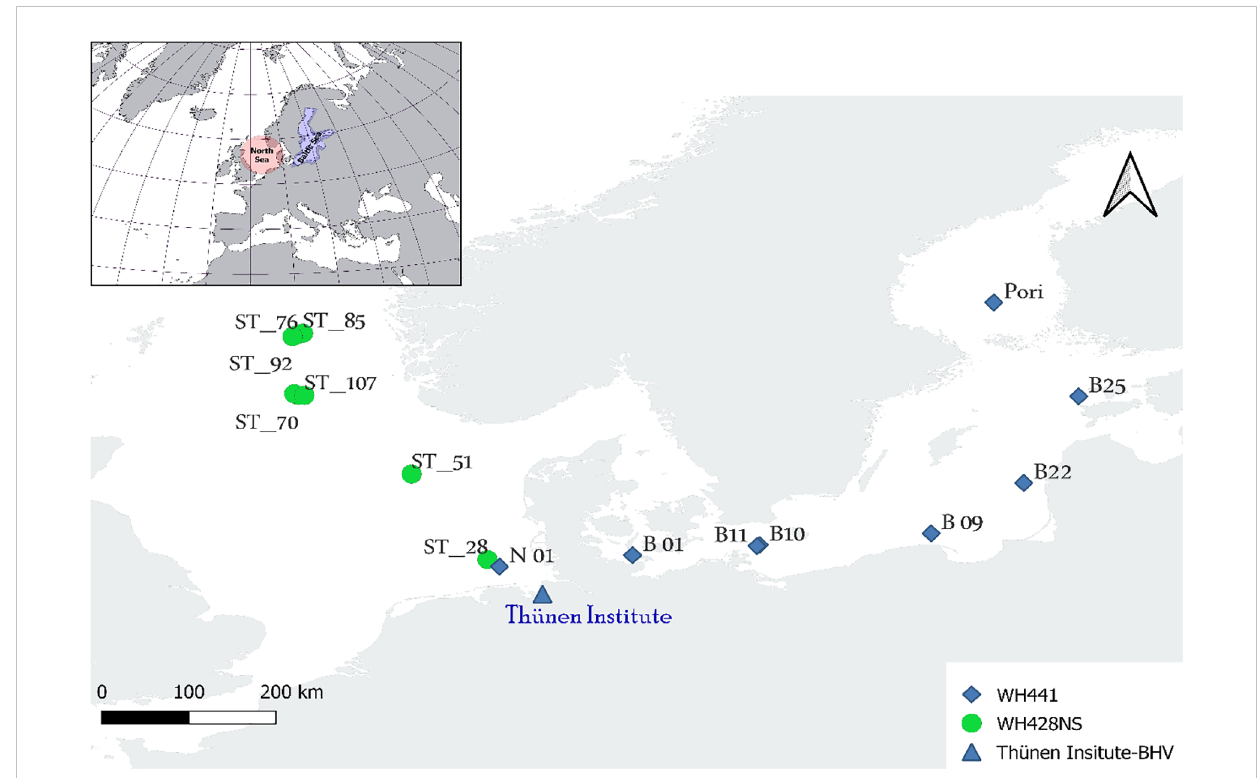
FIGURE 1 Sampling sites in the North Sea and Baltic Seas (Latitude: 2.00°-8.00° and Longitude: 52.00°-63.00°), WH441 and WH428 refer to the research missions aboard FFS Walther Herwig III conducted by the Thünen Institute in the Baltic Sea and North Sea, respectively. The map is constructed by